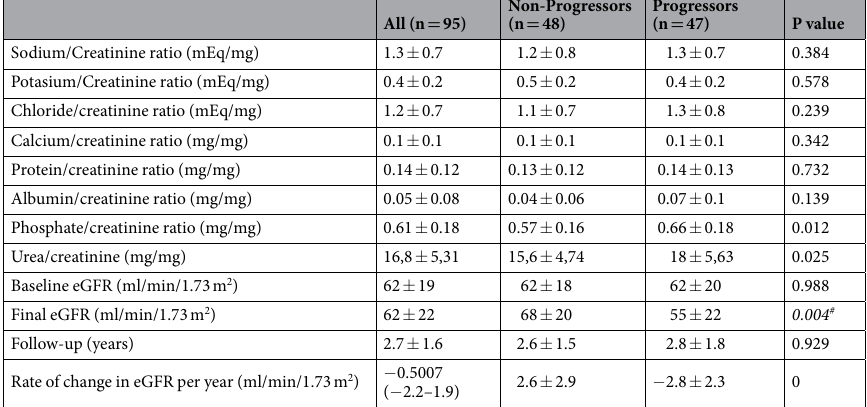
Table 3. Urine values and eGFR in Non-progressors and Progressors. Mean ± SD. # Different by definition because of division to non-progressors and progressors. Abbreviations: eGFR: Estimated Glomerular Filtration Rate; Hb1Ac: glycosylated hemoglobin.